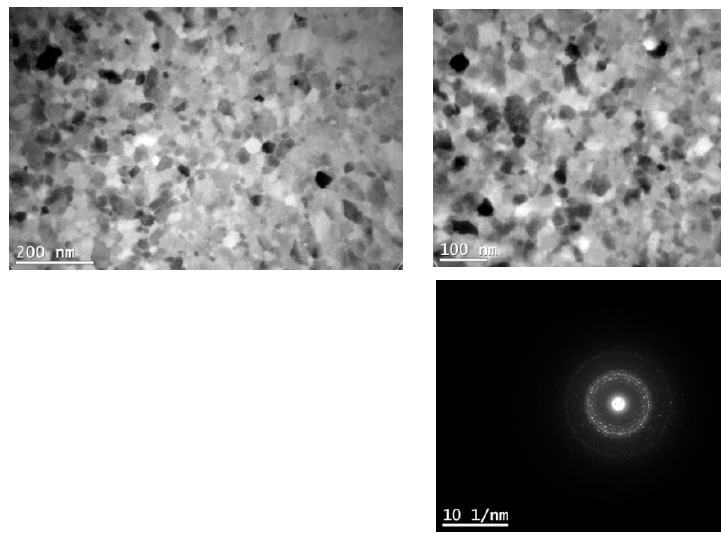
Figure 6. TEM micrograph of Sample 3 and corresponding diffraction pattern.